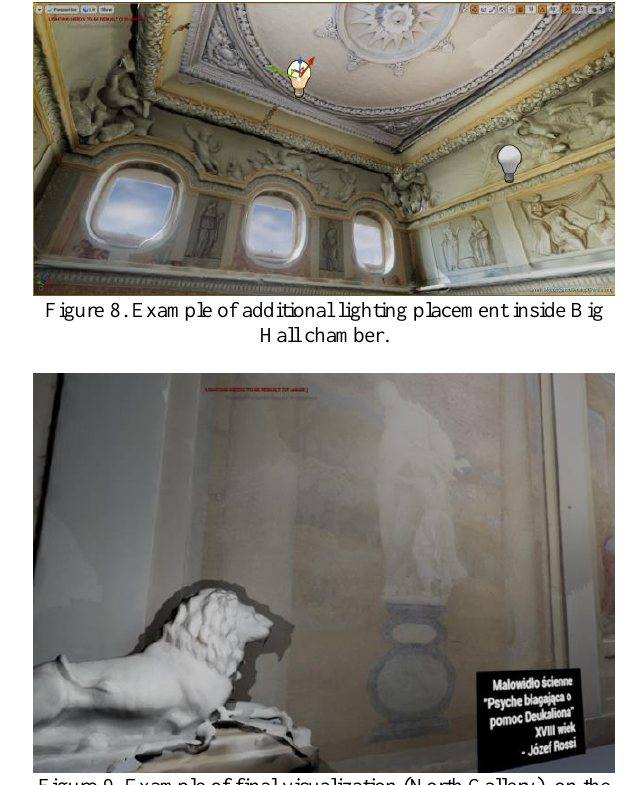
Figure 9. Example of final visualization (North Gallery), on the right-side HUD with additional information about wall painting is